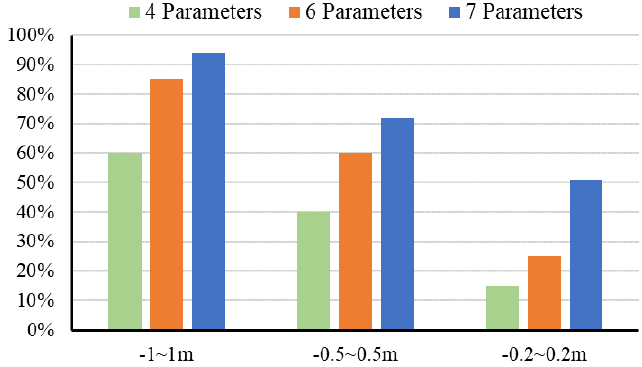
Figure 9. Comparison chart of the error value distribution of different parameter combination models.